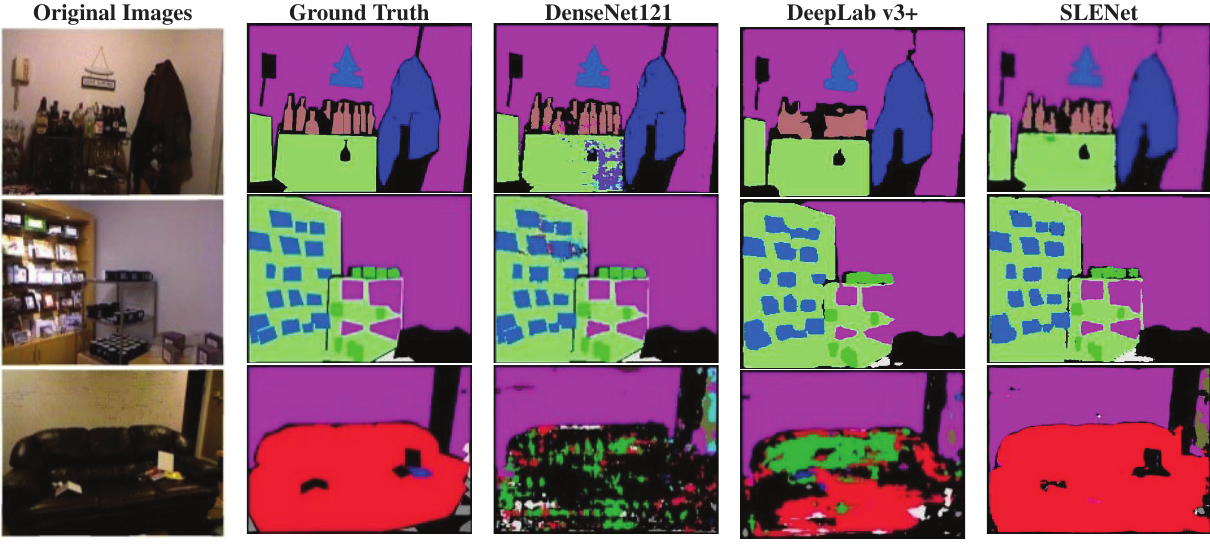
Figure 9. Qualitative comparisons among DenseNet121 model, Deeplab v3 model and our SLENet model on NYUDv2 RGBD dataset.